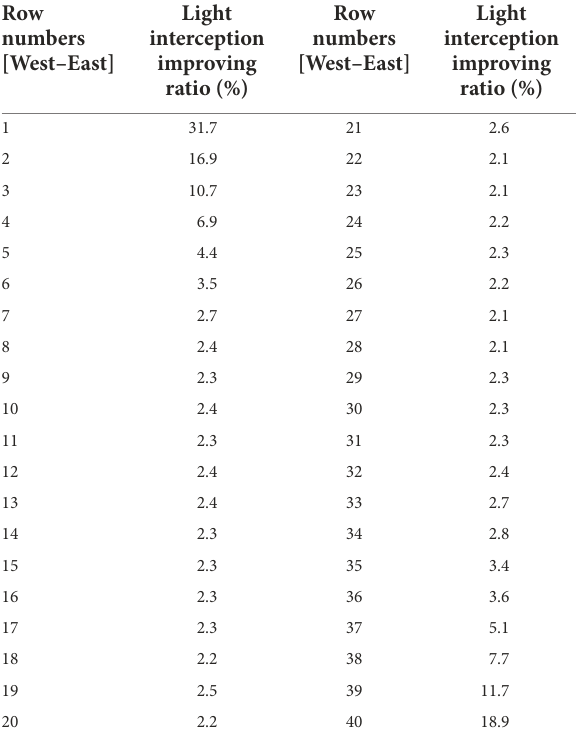
TABLE 4 Integrated compound canopy light interception gain of the final reflective film configuration scheme on December